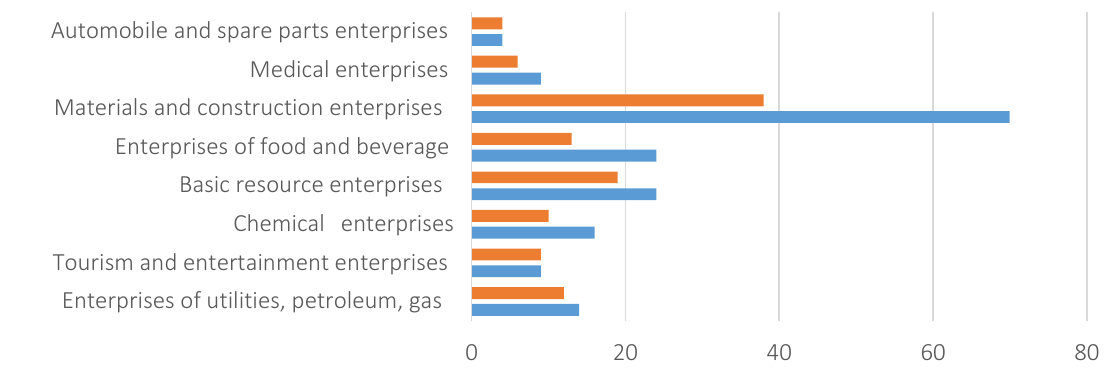
Figure 1. Statistics of enterprises with environmental information disclosure compared to surveyed enterprises